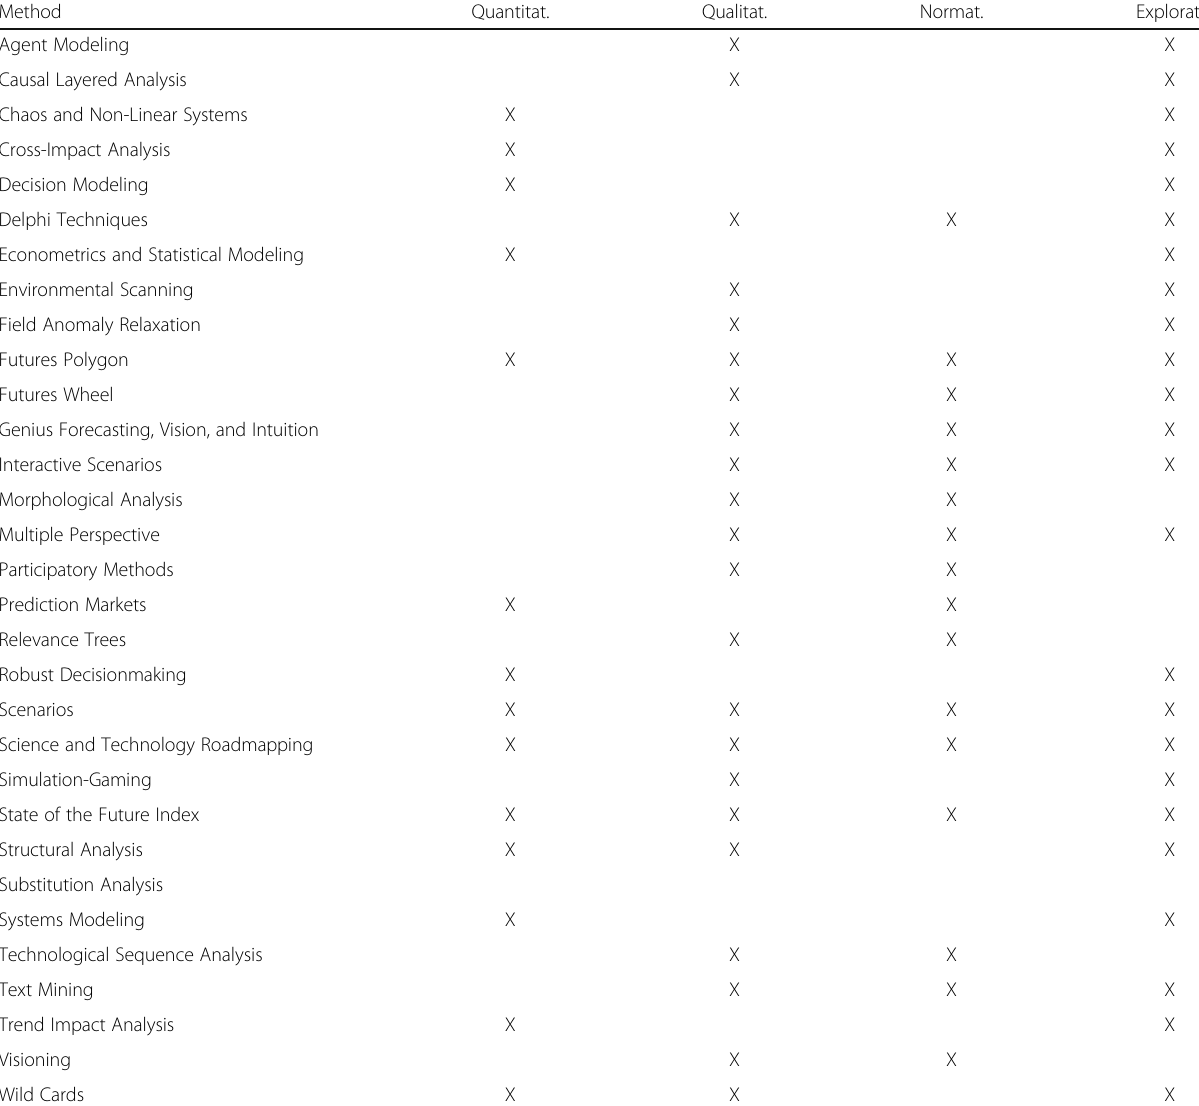
Table 2 Taxonomy from [11], Futures Research Methodology 3.0 Method Quantitat. Qualitat. Normat.